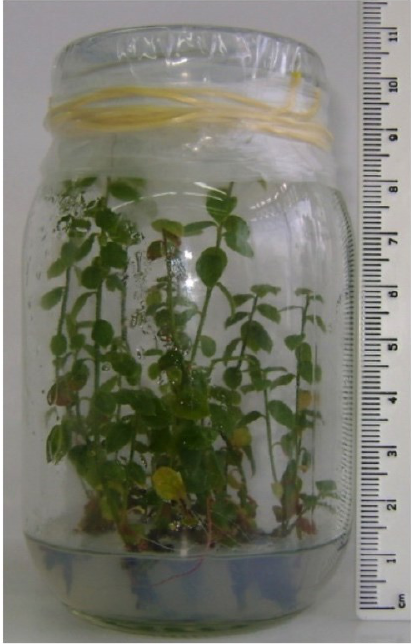
Figure 1. In vitro blueberry plants cv. Misty in supplemented Lloyd-McCown medium (see Experimental